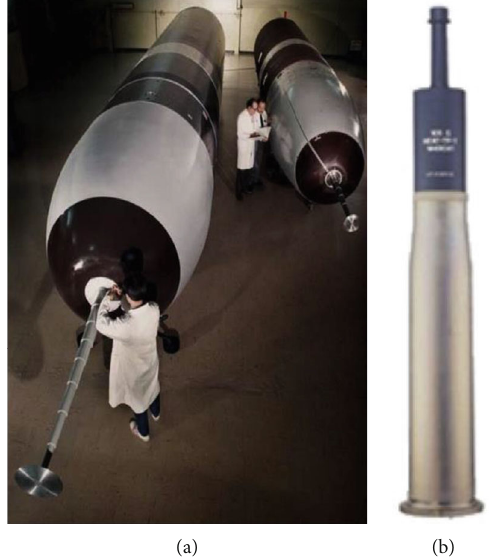
Figure 1: Some equipment with aerospike. (a) trident-II (left) and trident-I (right). (b) M490A1shell.